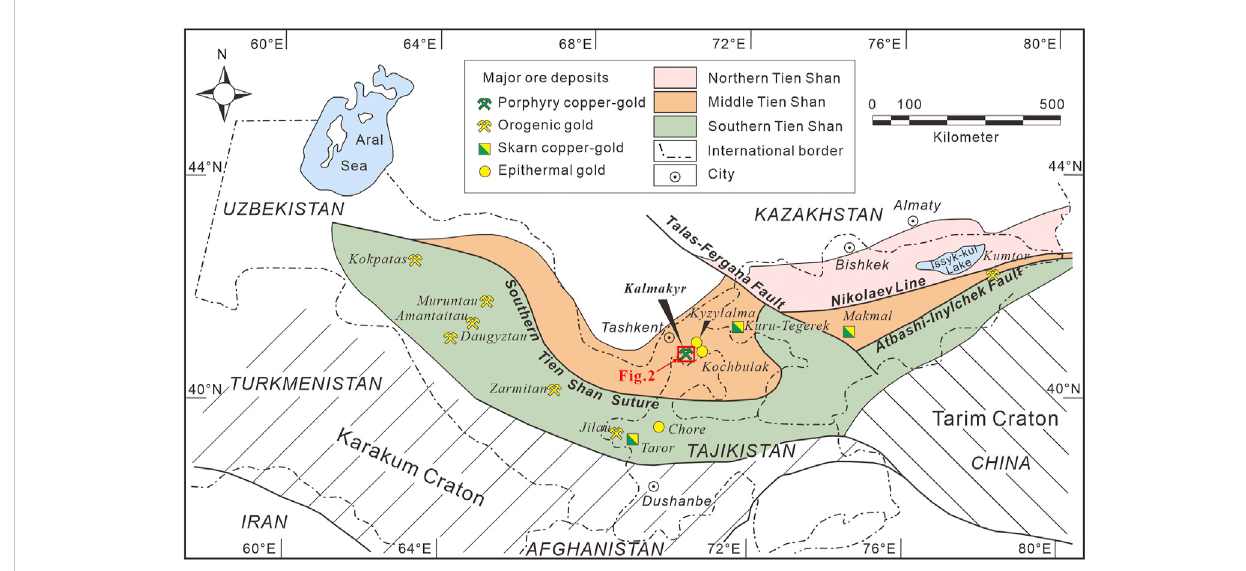
FIGURE 1 Simpli fi edgeological map oftheTien Shanorogenic belt showing thelocation ofmajor copperand gold deposits (modi fi edfrom (Zhaoet al.,2017). The area shown in Figure 2 is